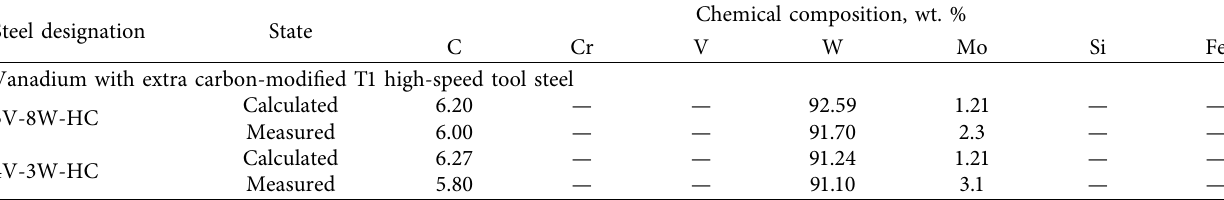
Table 7: Chemical composition MC-SHIP carbide for T1 high-speed tool steel and its diferent variants (as solidifed). Steel designation Vanadium with extra carbon-modifed T1 high-speed tool